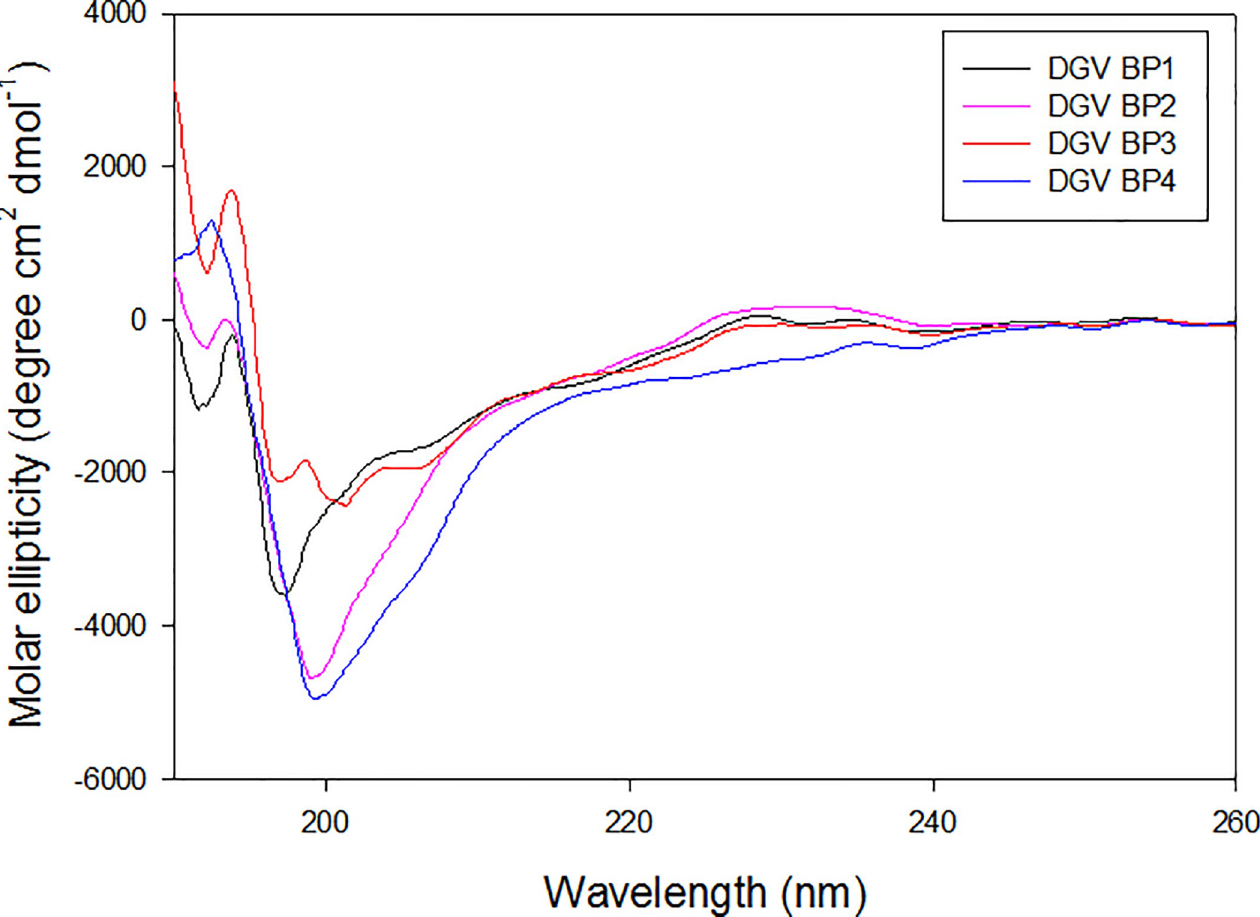
Fig 2. Secondary structure analysis of synthetic affinity peptides used in this study. Circular dichroism (CD) spectra of synthetic peptides (DGV BP1–5), at a concentration of 50 μ M, were recorded on a JASCO J-1500 CD spectrometer.